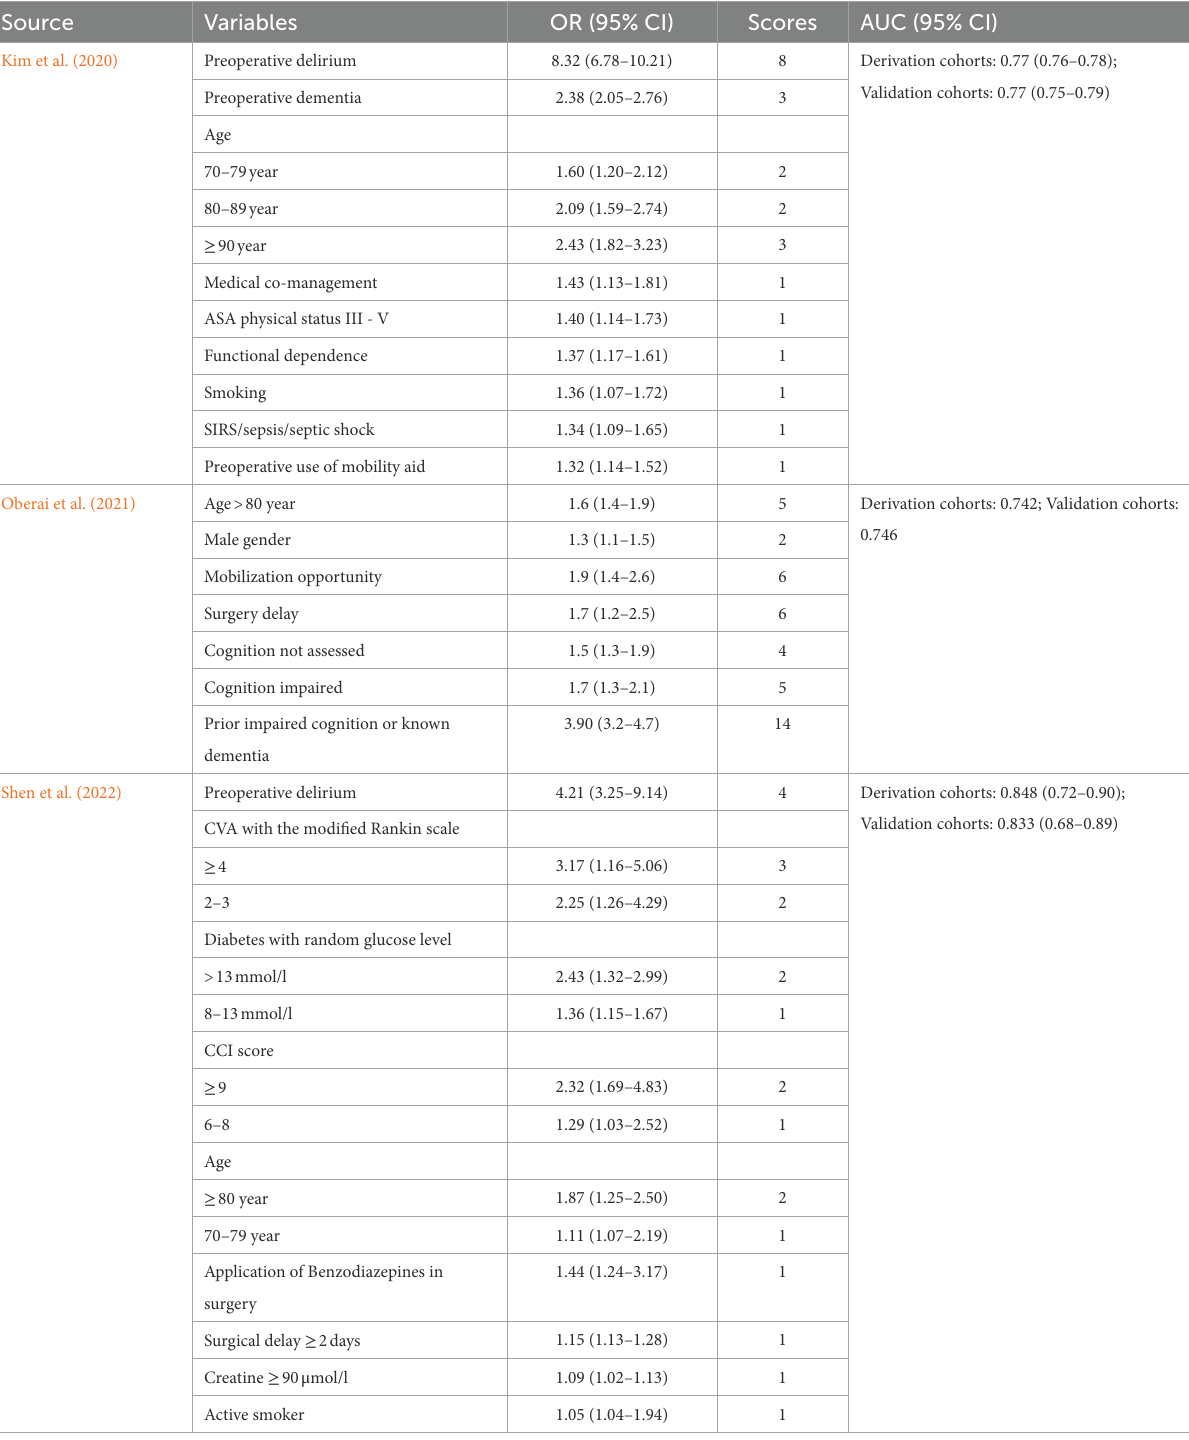
TABLE 2 Risk prediction models for postoperative delirium in geriatric patients with hip